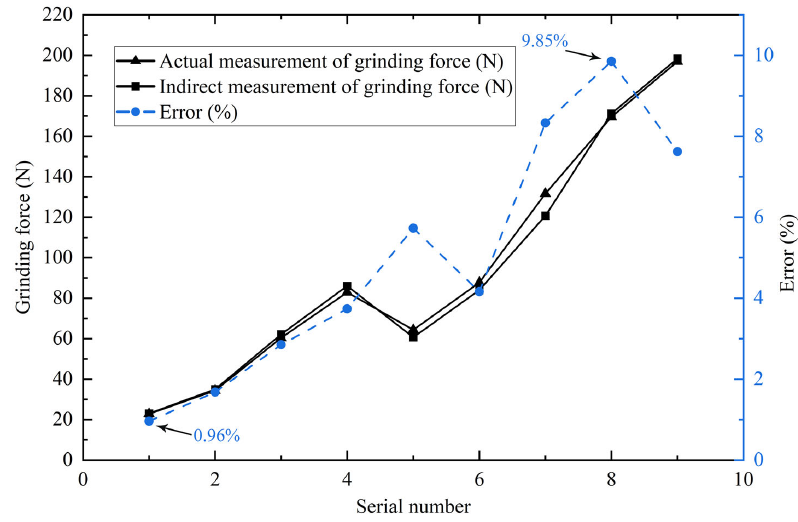
Figure 6. Comparison between the actual measured grinding force and the indirectly measured grinding force. Table 2. Grinding process parameters.